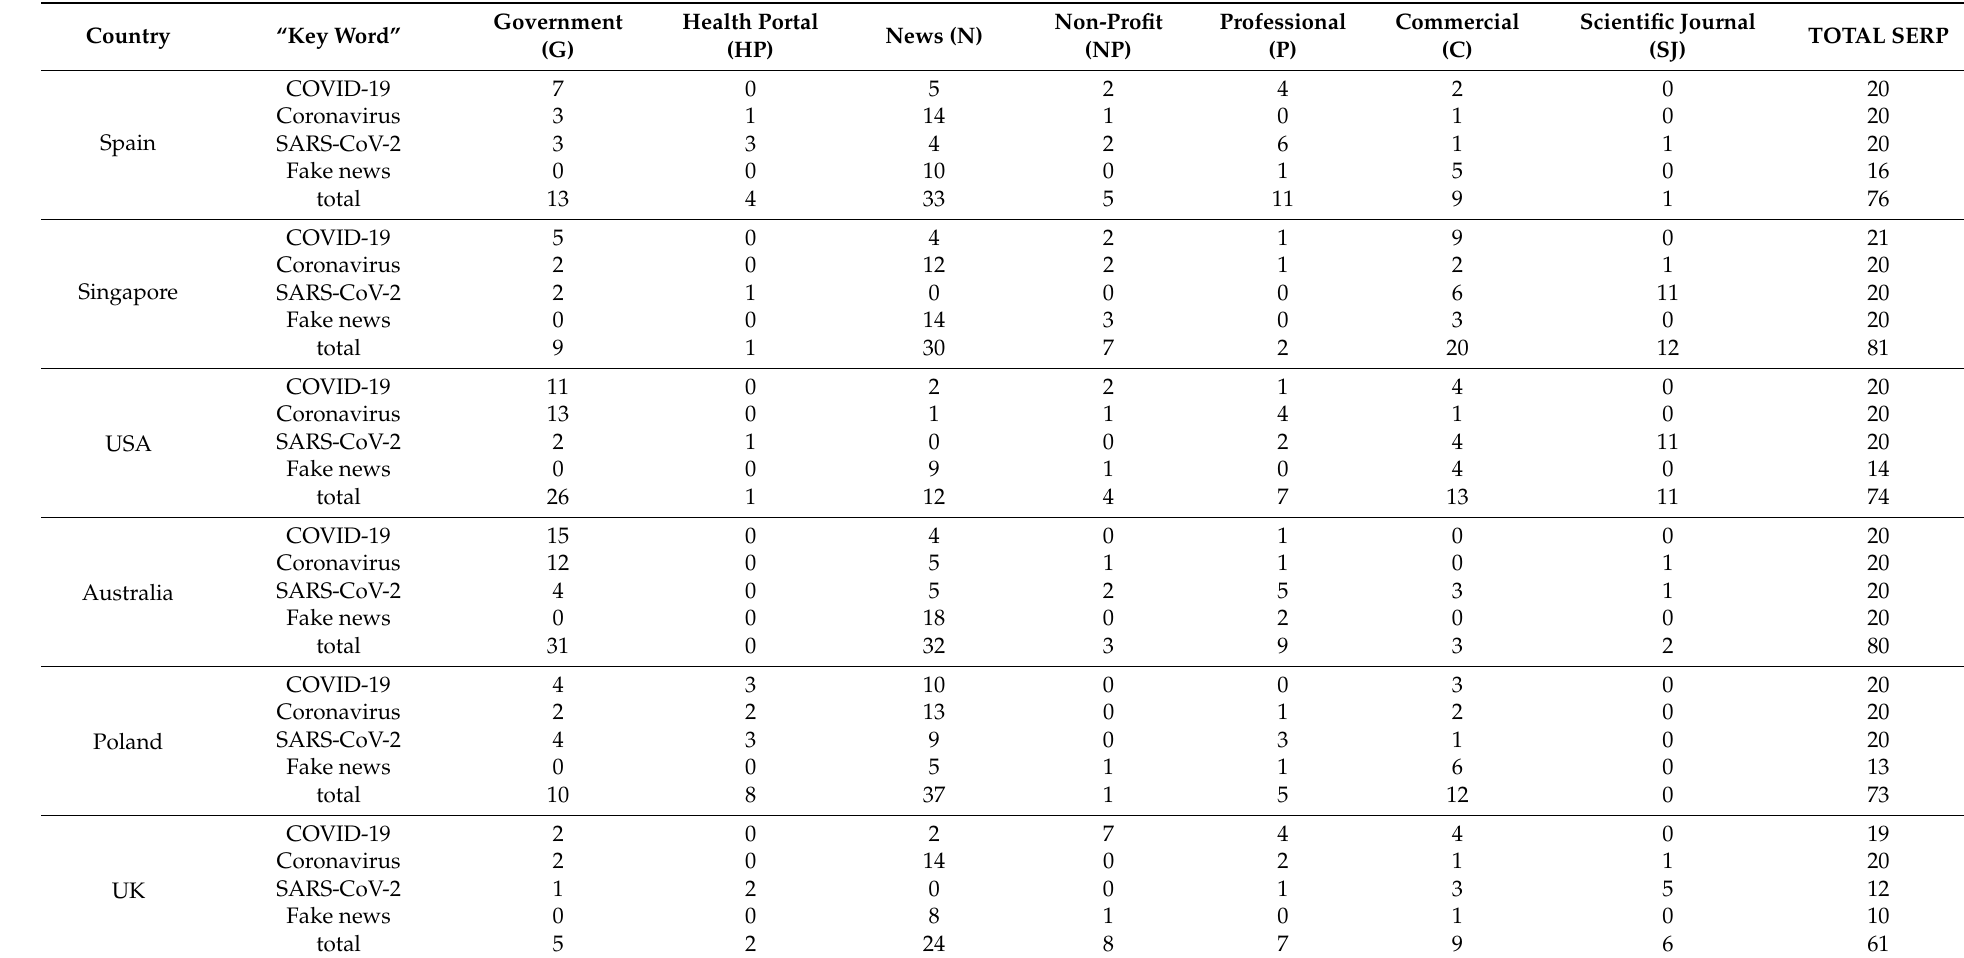
Table 1. Search engine results page (SERP) according to web pages typology ( n =